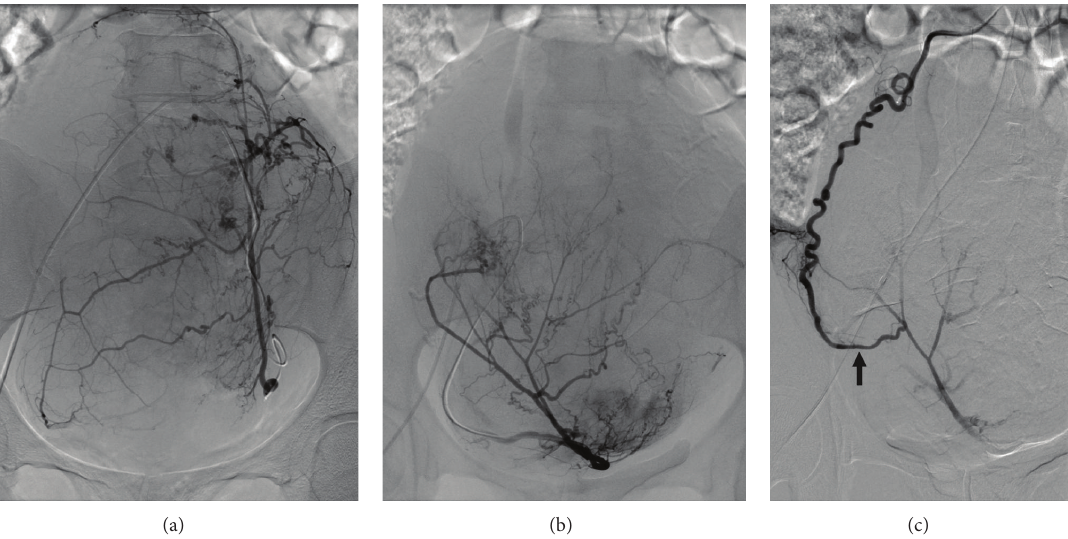
Figure 2: Left (a) and right (b) uterine and (c) right ovarian arteriographic images. (a) Enlarged left uterine artery supplying more than half of the enlarged uterus, with no discrete differentiation of the numerous hypervascular myomas. (b) Enlarged right uterine artery, with similar findings, albeit in a smaller degree, of the left side. (c) Following UAE, tortuous and enlarged right ovarian artery shows continuity with a superolateral branch of the right uterine artery, via a prominent uteroovarian anastomotic arterial branch (black arrow). Not embolized, this ovarian artery maintains some intrauterine flow following fibroid